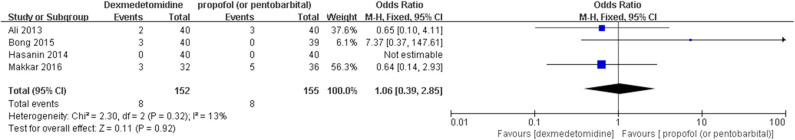
Comparison of pediatric EA or ED between dexmedetomidine and propofol (or pentobarbital) groups after sensitivity analysis.